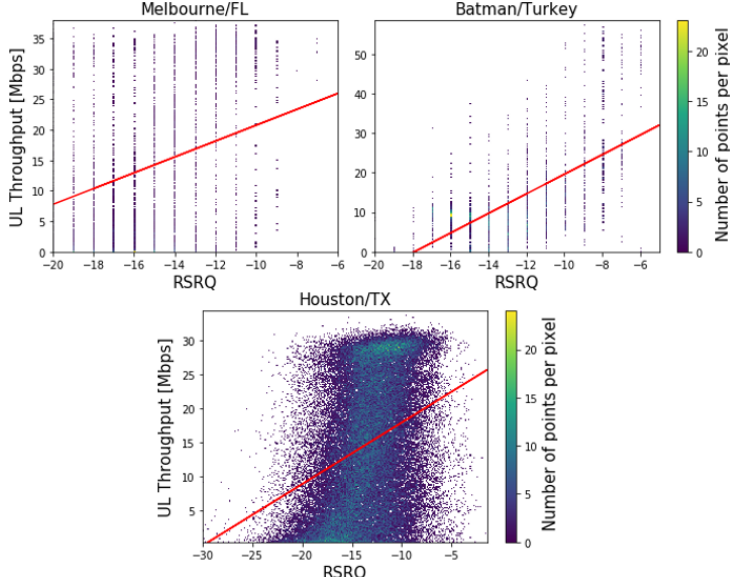
Figure 8. Scatter plot of RSRQ and UL throughput. While the trend line shows an expected increase with the RSRQ, the density of the points is not as clearly concentrated as in the RSRP comparison with the broader spreads at each RSRQ value. Therefore, the correlation between the UL throughput and RSRQ is expected to be lower than the correlation between the UL throughput and RSRP. The third LTE parameter with a high potential for accurate UL throughput prediction is signal-to- noise power (SNR). This metric applies to the baseband DL signal after down-conversion from the high-frequency wideband carrier. This measurement is expected to correlate closely with DL throughput and maintain a correlation with the UL throughput, although not directly, as in the DL direction. That is confirmed with measured data presented on the scatter plot in Figure 9 together with a linear regression line.